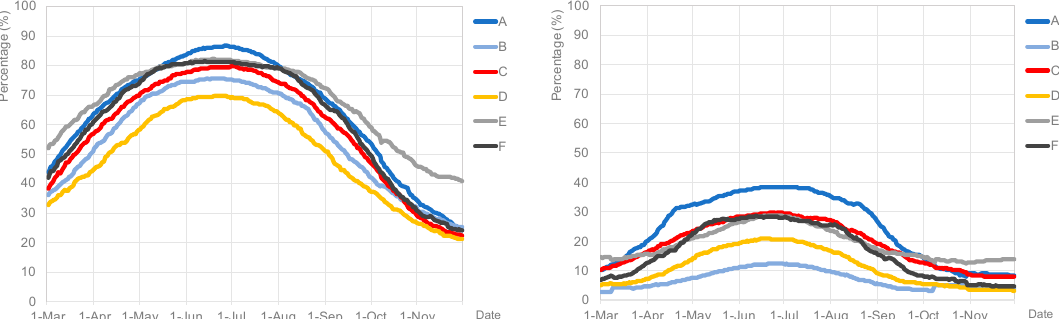
Figure 8. Percentages of ground-level surface with direct sunlight for three or more hours ( left ) and six or more hours ( right ) from March to November for study sites A to F when FAR is 2.5.